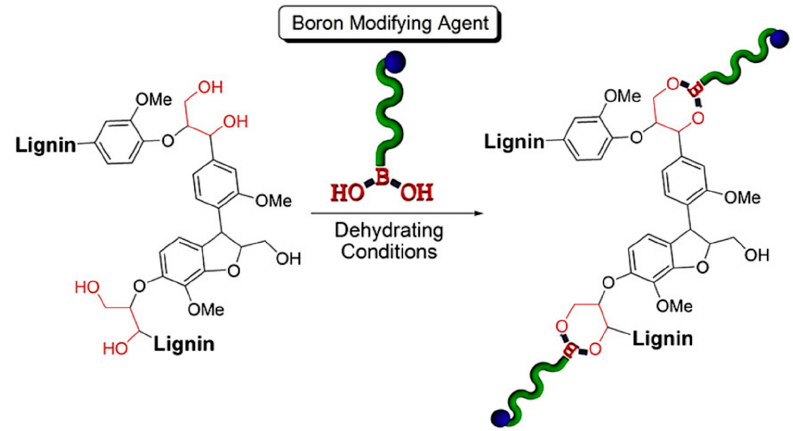
Figure 37. Modi fi cation of organosolv lignin using arylboronic acid end-functionalized polymers. Reproduced with permission